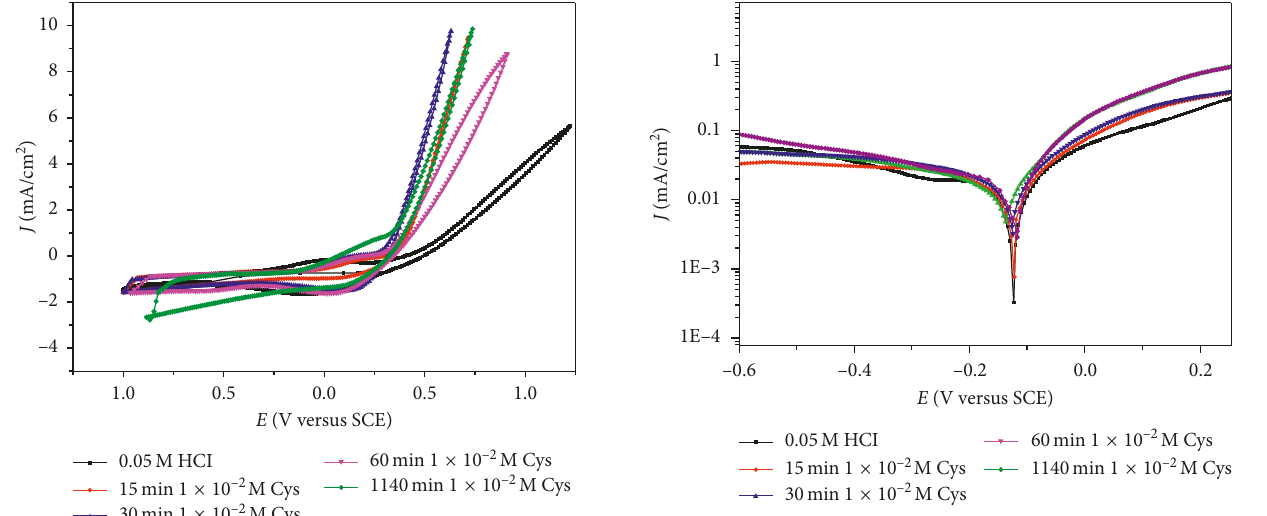
Figure 6: Polarization curves of brass in 0.05M HCl solution after immersion in 1 · 10 − 2 M cysteine solution for various periods of time (15, 30, 60, and 1140min; scan rate,